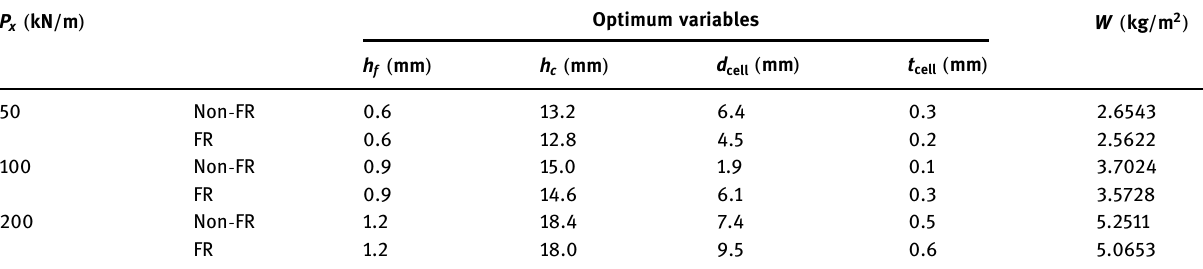
Table 7: ICA results for the optimal design of FR and non - FR simply supported sandwich beams in terms of weight ( = L 0.3 m )